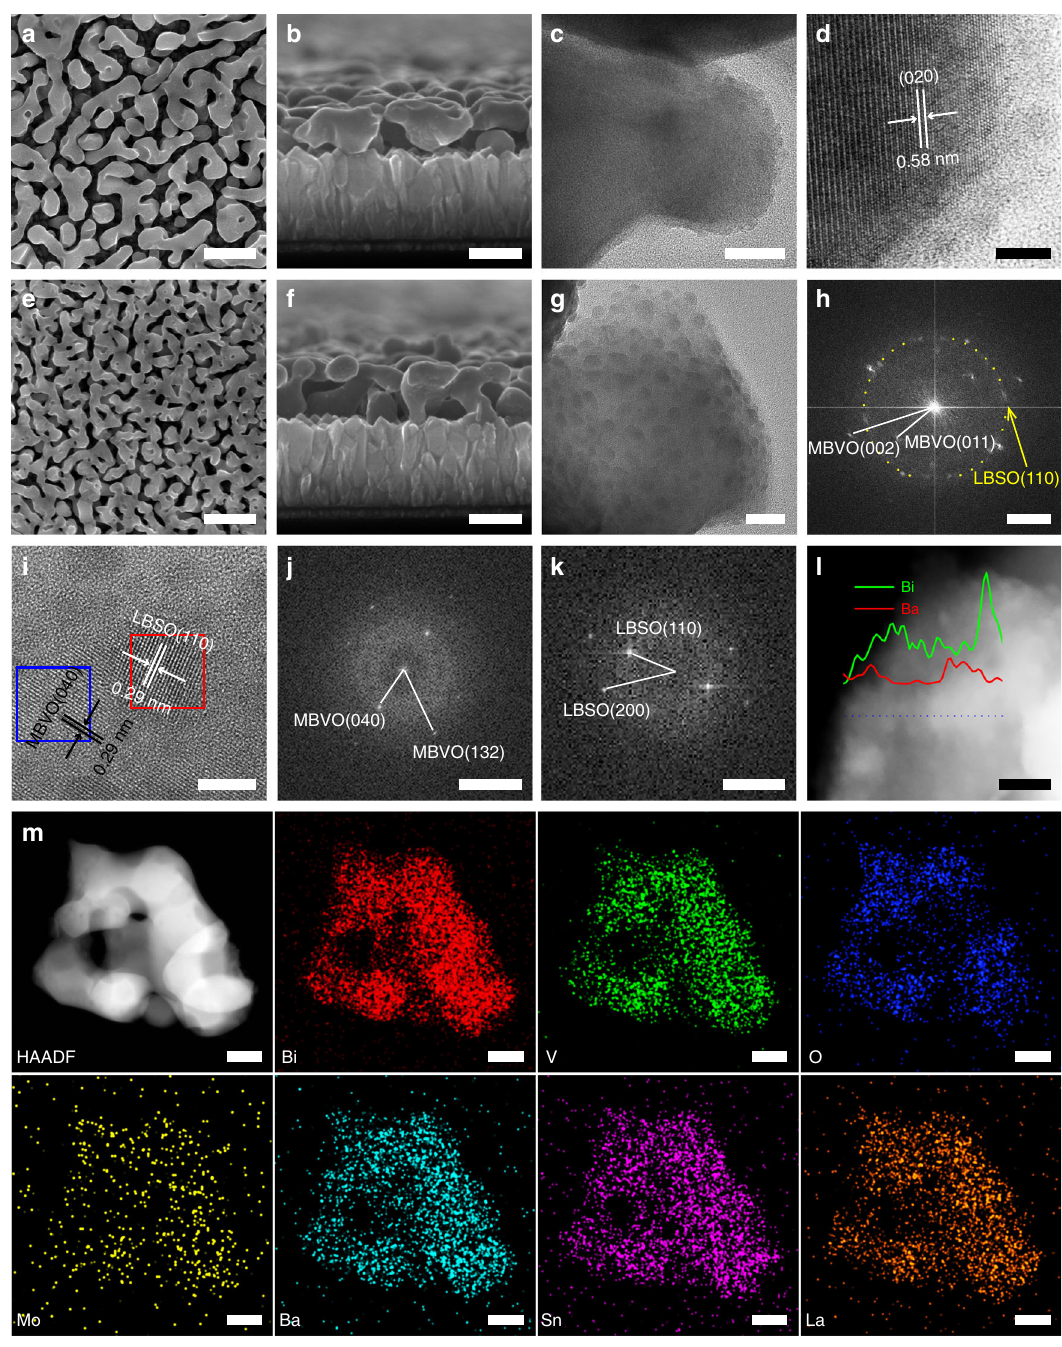
Fig. 2 Characterizations of MBVO and LBSO-MBVO fi lms. a SEM top-view, b SEM cross-section, c TEM, and d HRTEM image of MBVO fi lms. e SEM top- view, f SEM cross-section, g TEM image, h FFT-transformation image and i HRTEM image of LBSO-MBVO-2 fi lm. j FFT-transformation image of MBVO matrix (area labeled in blue in Figure i ). k FFT-transformation image of LBSO nanocrystal (area labeled in red in Figure i ). l HAADF image and corresponding EDX-line scanning of LBSO-MBVO-2 fi lm. m TEM-EDS analysis of LBSO-MBVO-2 fi lm. Scale bars: ( a , e ) 500 nm, ( b , f ) 250 nm, ( c , g ) 20 nm, ( d , i ) 5 nm, ( h ) 2 1/nm, ( j , k ) 5 1/nm, ( l ) 10 nm and ( m ) 100